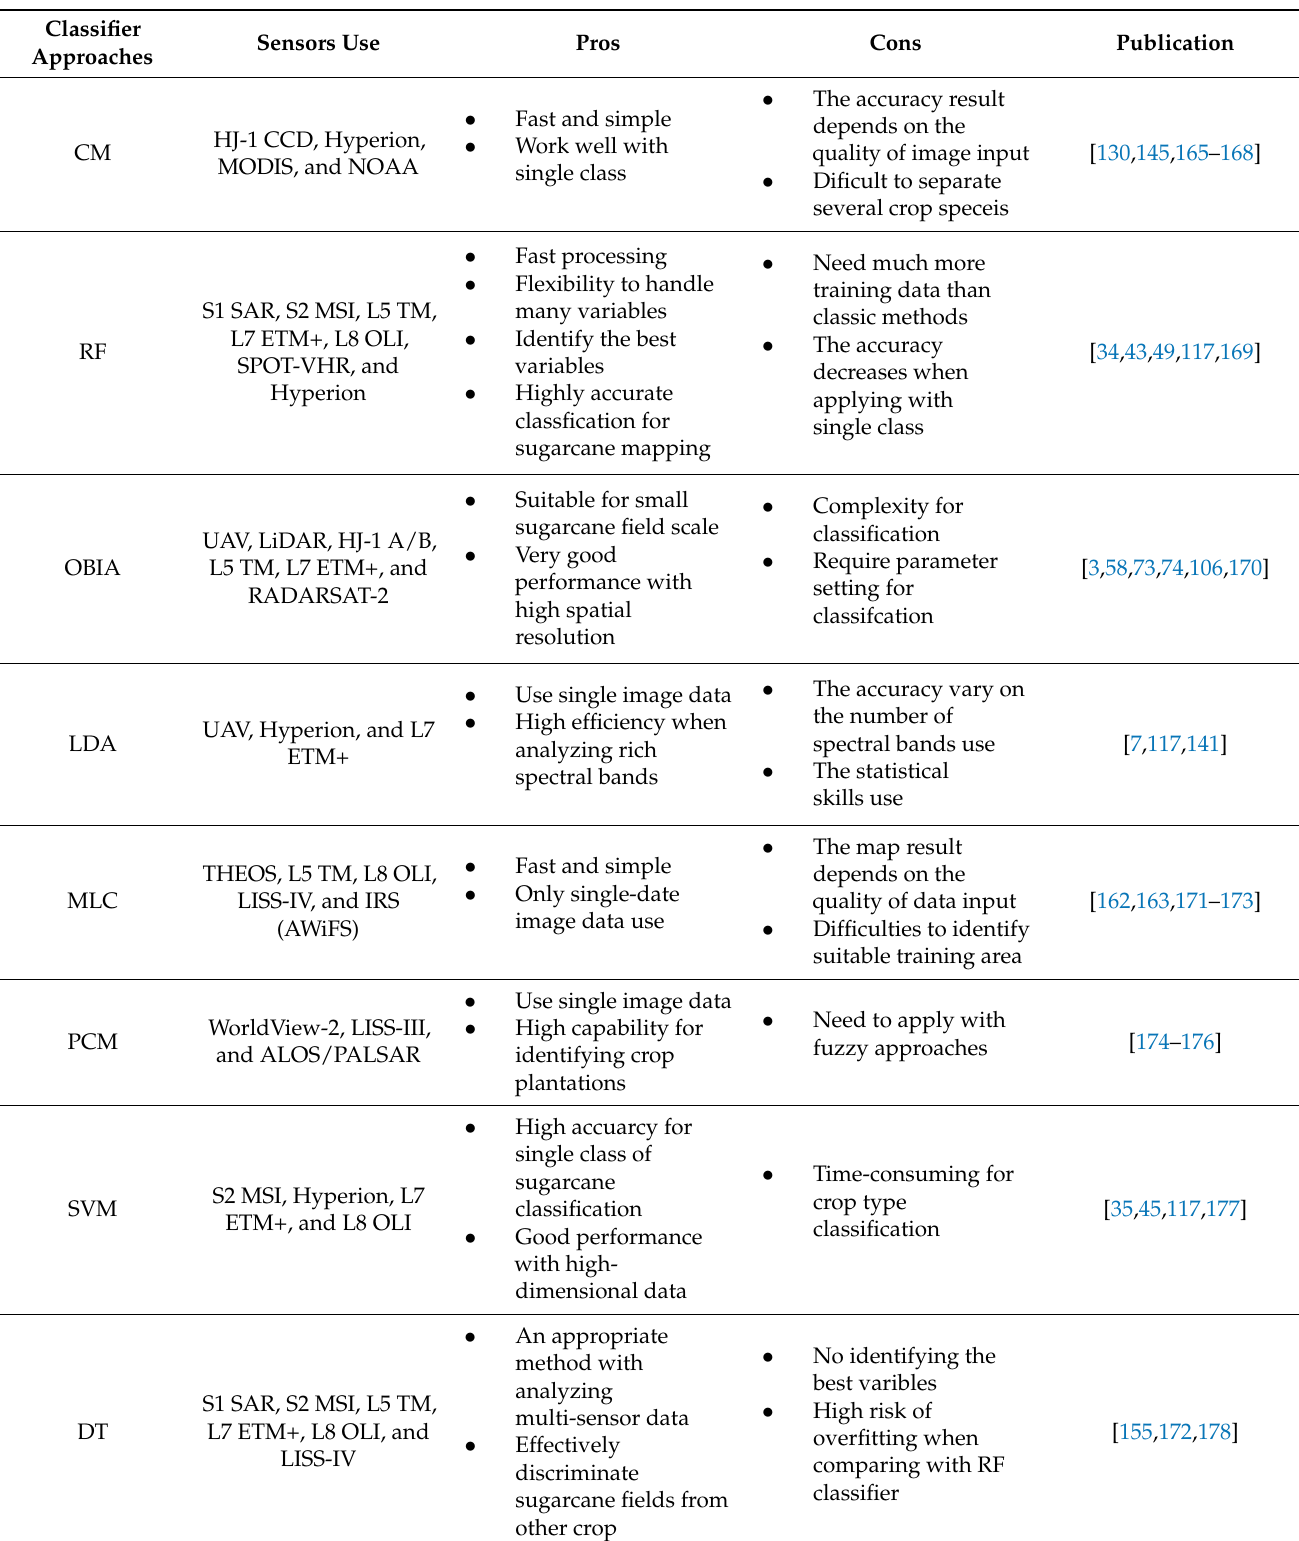
Table 4. Summary of different classifier methods, sensors use, and pros and cons for sugarcane mapping.